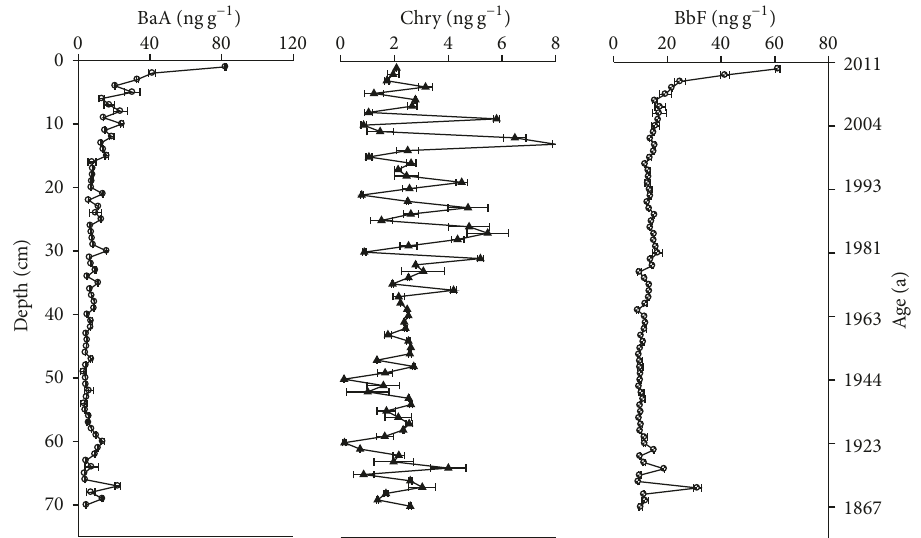
Figure 4: Individual concentration in the sediment.